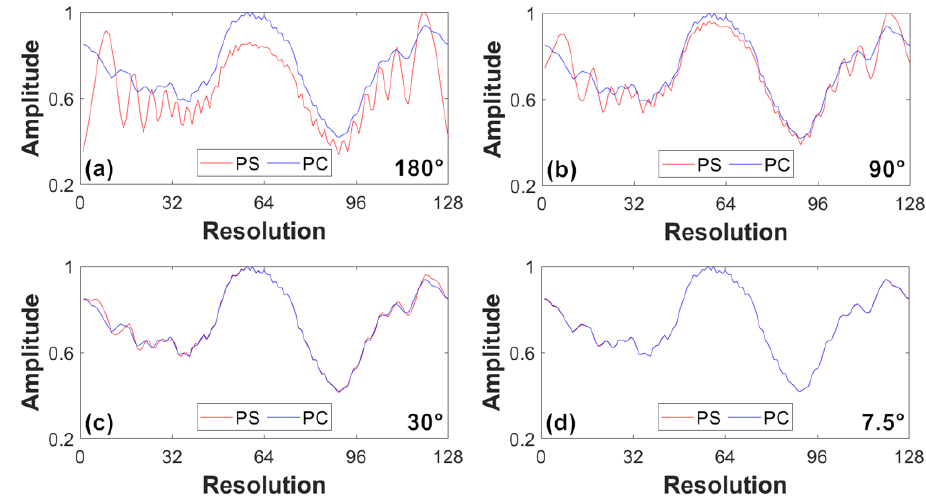
Figure 8. Error of the diffraction results between PS (red line) and PC (blue line) method in amplitude with different flare angles of WRP. ( a ) 180 ◦ , ( b ) 90 ◦ , ( c ) 30 ◦ and ( d ) 7.5 ◦ .